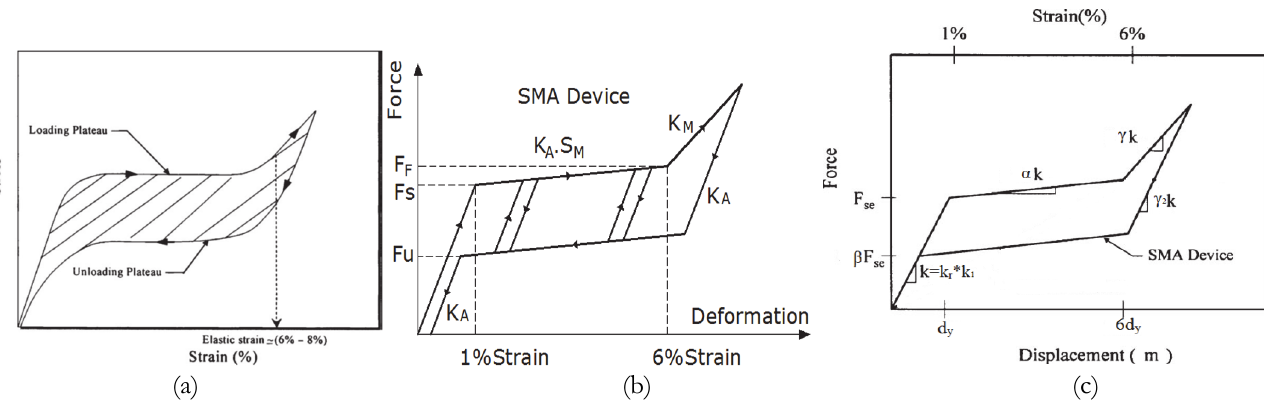
Figure 3: Hysteresis of SMA, (a) A typical stress–strain curve for superelastic SMA [17, 19]; (b) Load–displacement relationship of the chosen superelastic SMA model; (c) Hysteretic parameters of SMA considered in the analysis of this